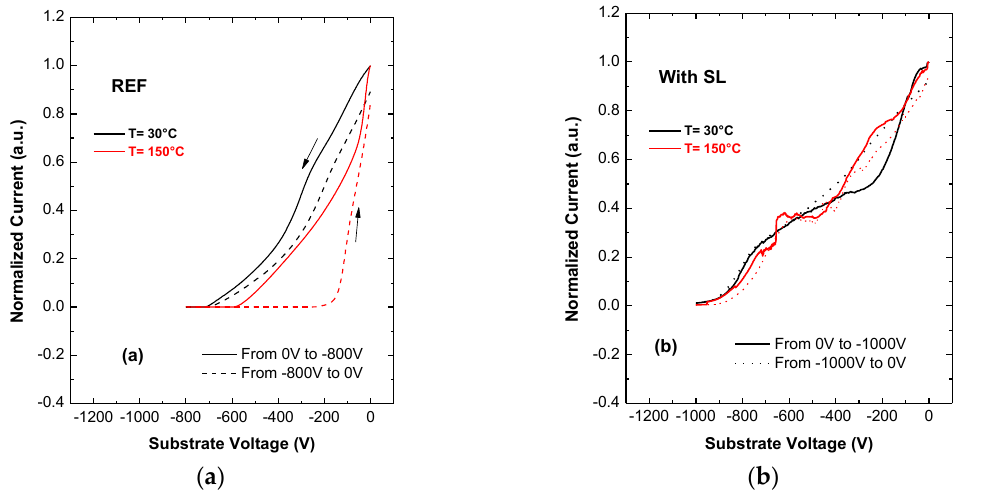
Figure 7. Substrate ramp measurements at room and high temperature. ( a ) Sample without SL, substrate voltage from 0 V to −800 V and ( b ) sample with SL, substrate voltage from 0 V to −1000 V.